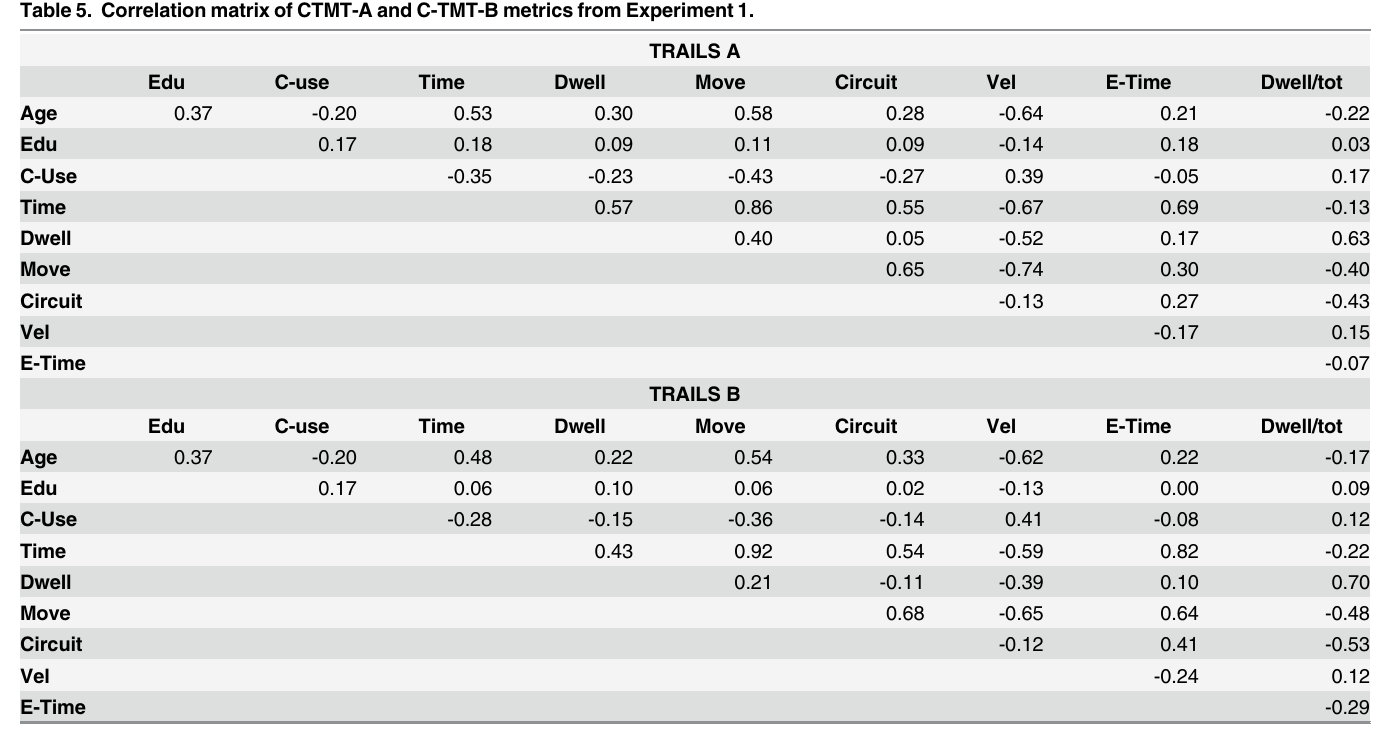
different ages in Fig 6 (top, blue diamonds). Velocity z-scores did not vary significantly with education or handedness, but were slightly increased in men [r = 0.16, t(163) = 2.08, p < 0.05]. There was no significant correlation of velocity z-scores with the dwell-time/total-time ratio [r = 0.04, NS]. C-TMT-B: analysis by subject. C-TMT-B completion times are shown in Table 4 (center). Completion times averaged 60.8 s, divided into dwell-time (27.0%), move-time (63.8%), and error time (9.2%).